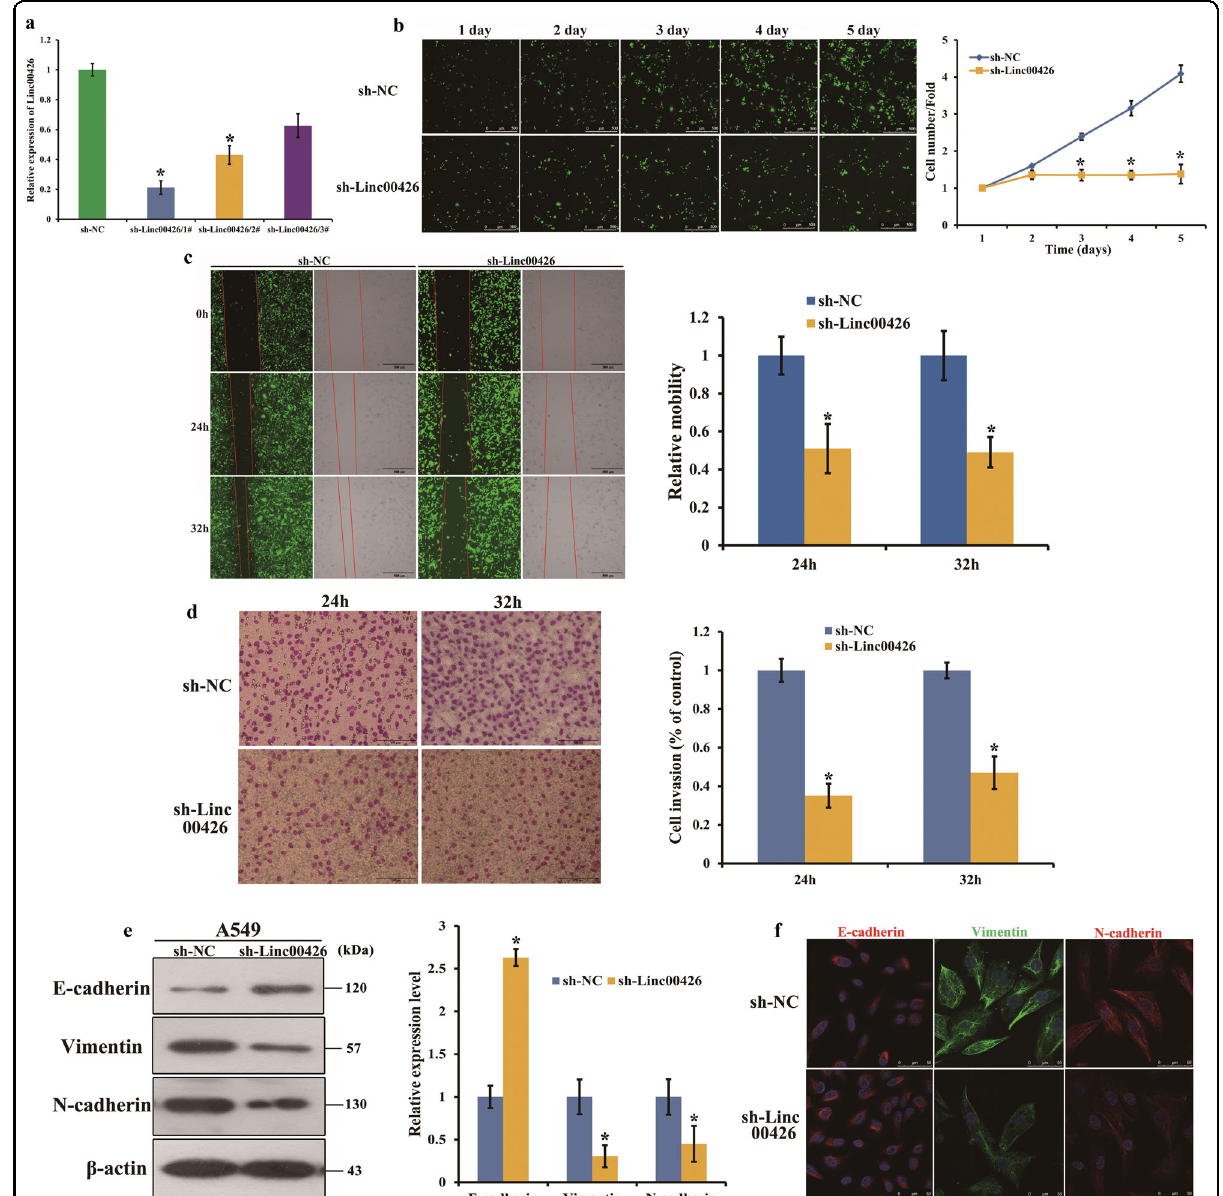
Fig. 2 Downregulation of Linc00426 leads to signi fi cantly inhibit proliferation, metastasis, and invasion of LUAD in vitro. a Quanti fi cation of Linc00426 in A549 cells after infection with sh-NC and three different shRNA (sh-Linc00426-1#, sh-Linc00426-2#, and sh-Linc00426-3#). RT-qPCR was employed to examine the infection ef fi ciency. b Cell proliferation was detected by Celigo Image Cytometer on the reading board once a day for 5 days. Scale bar = 500 μ m. c Effects of Linc00426 knockdown on cellular mobility detected by wound-healing assay. Photos were taken by Celigo Image Cytometer at 0, 24, and 32 h, respectively. Scale bar = 500 μ m. d Effects of Linc00426 knockdown on invasion ability determined using Transwell assay. Photos were taken by optical microscope at 24 and 32 h, respectively. Scale bar = 100 μ m. e Expression levels of EMT-related markers were detected by Western blot in A549 cells infected with sh-NC and sh-Linc00426. f Expression of EMT-related markers in A549 cells with sh-NC and sh-Linc00426 by immuno fl uorescence analysis. The nuclei were counterstained using DAPI. Scale bar = 50 μ m. Experiments were performed three times and data were presented as mean ± SD. * P < 0.05. Student ’ s t